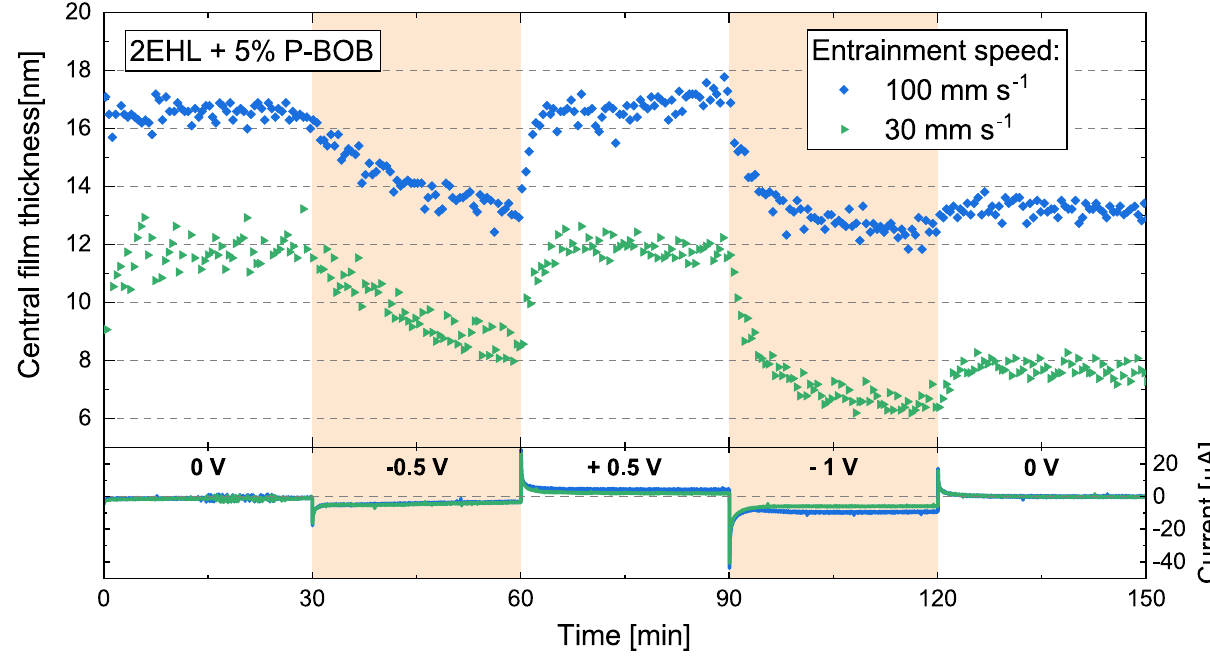
Figure 3. Electro-response of the central film thickness for 2EHL + 5% P-BOB solution at 100 and 30 mm s entrainment speeds. The applied potential was changed every 30 min. The bottom part of the figure shows the current traces corresponding to the applied potentials.